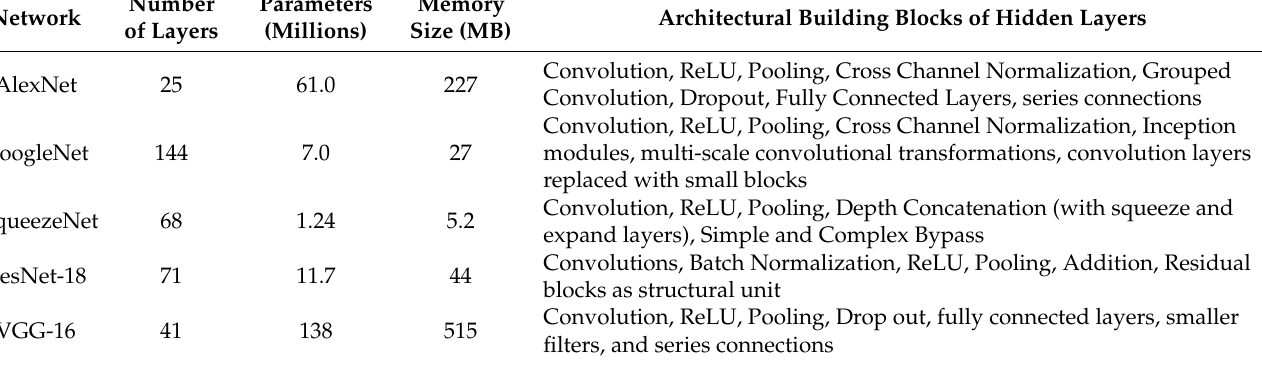
Table 5. Comparison of pretrained deep learning